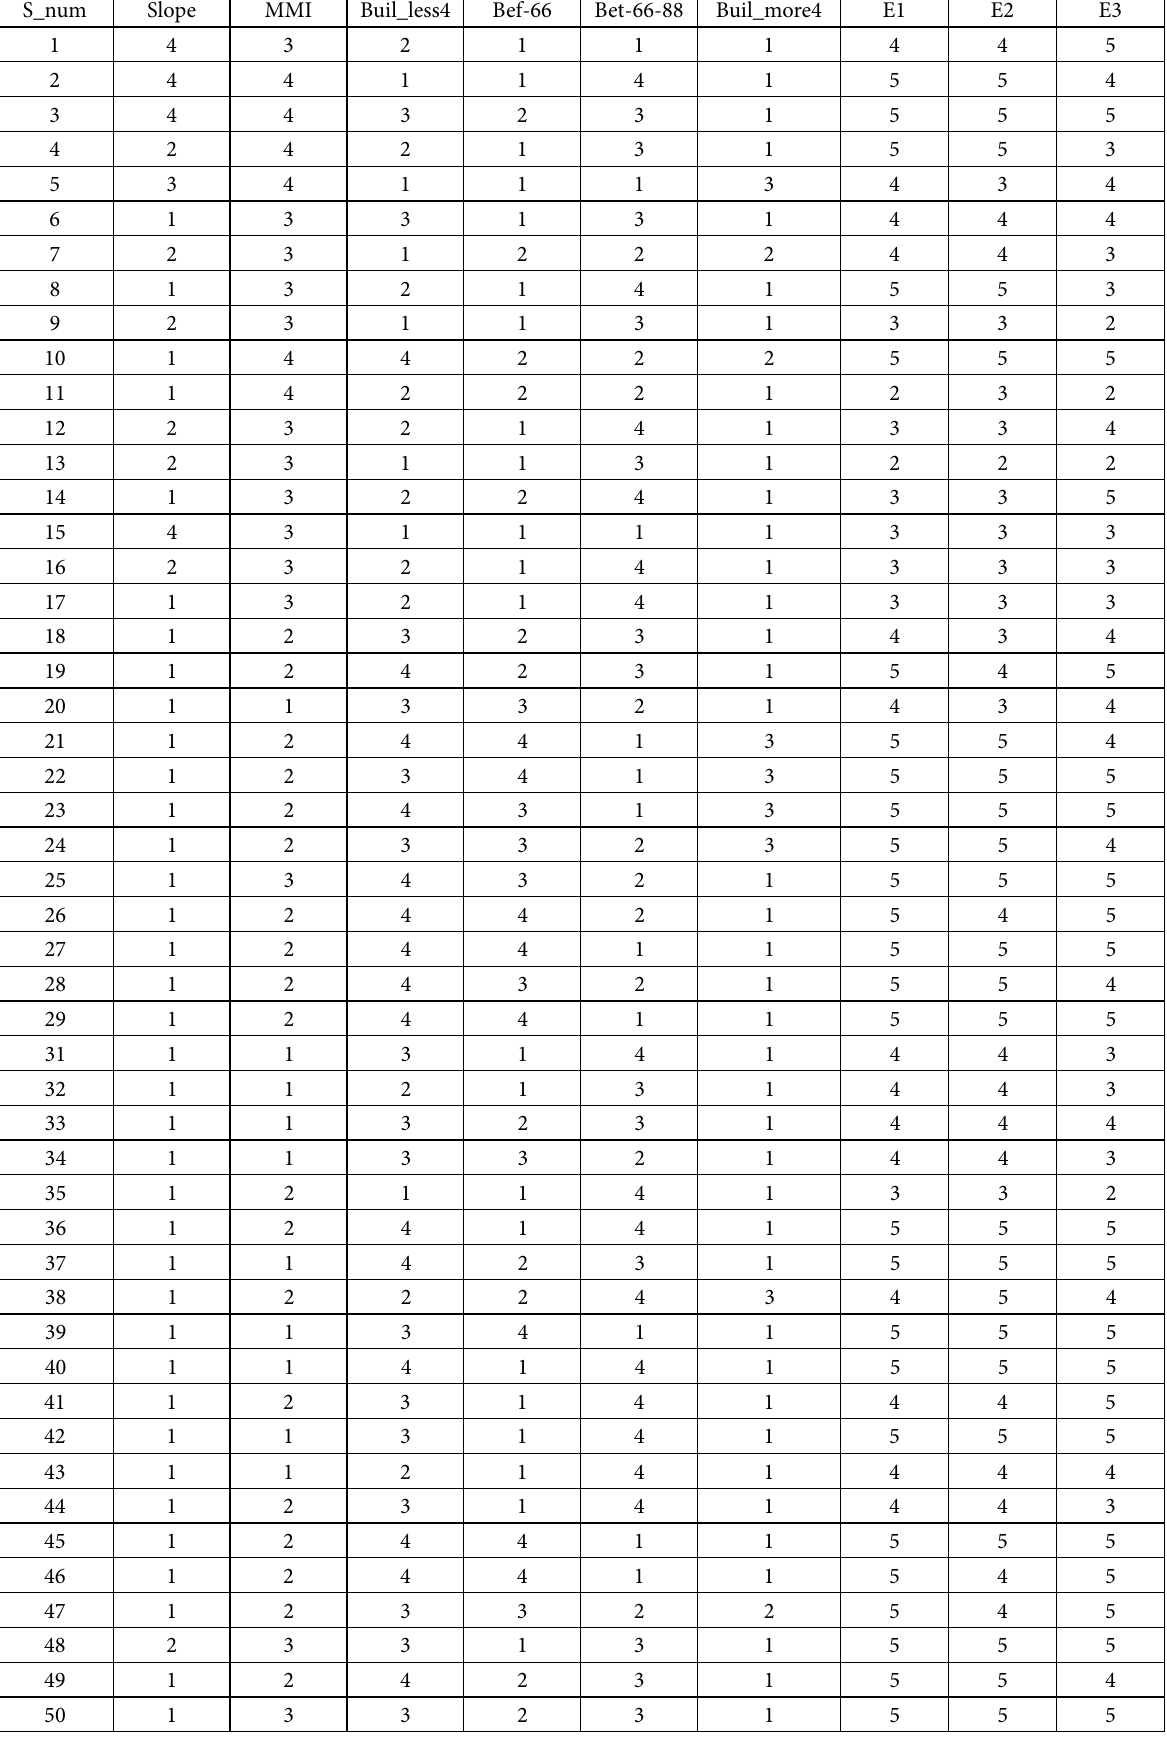
Table 1. Information table of sample